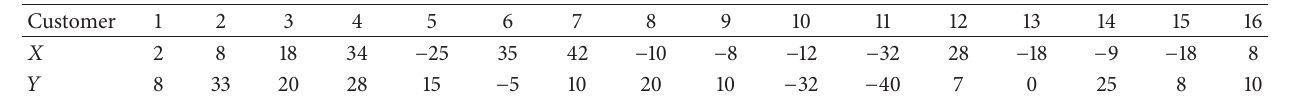
Table 2: Coordinate of customer.